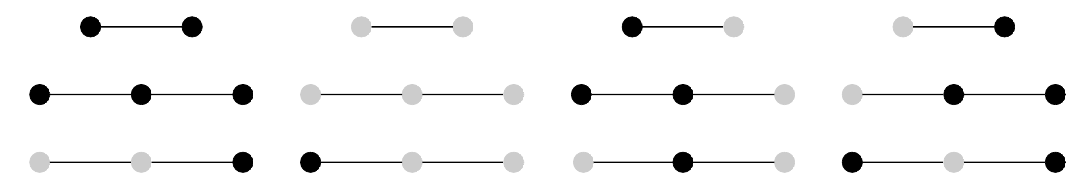
Figure 1 . Trees contributing to the first and second order expansion of the free